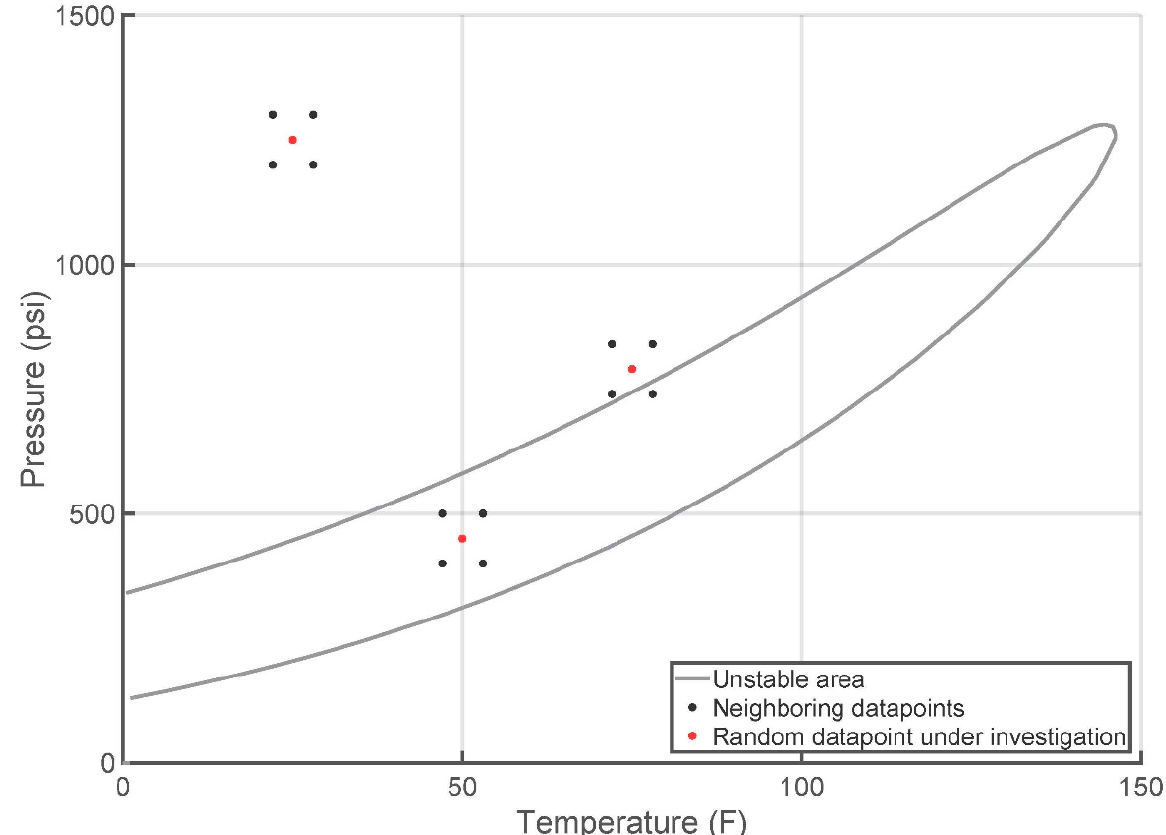
Figure 3. Procedure to pick points close to the phase boundary.